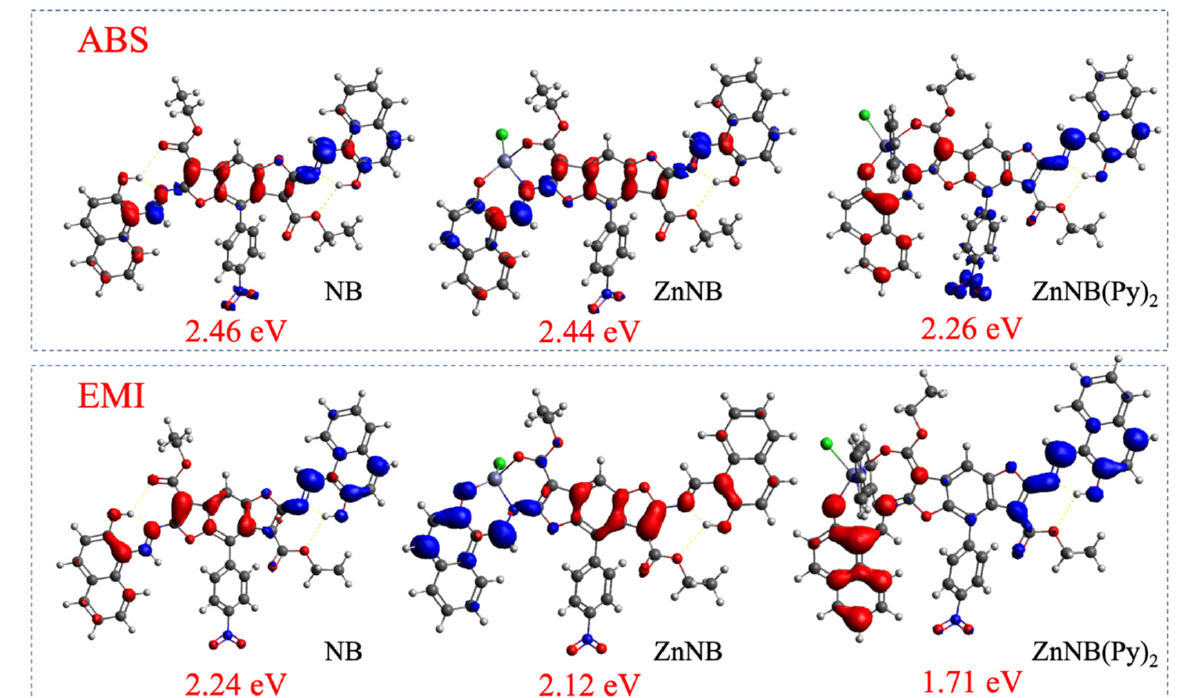
Figure 3. Differential transition densities (r diff ) between ground ( above ) and first excited state ( below ). The blue lobes are the positive values, the red lobes are the negative ones. The density iso-level plot is 0.002 |e|/a 03 .